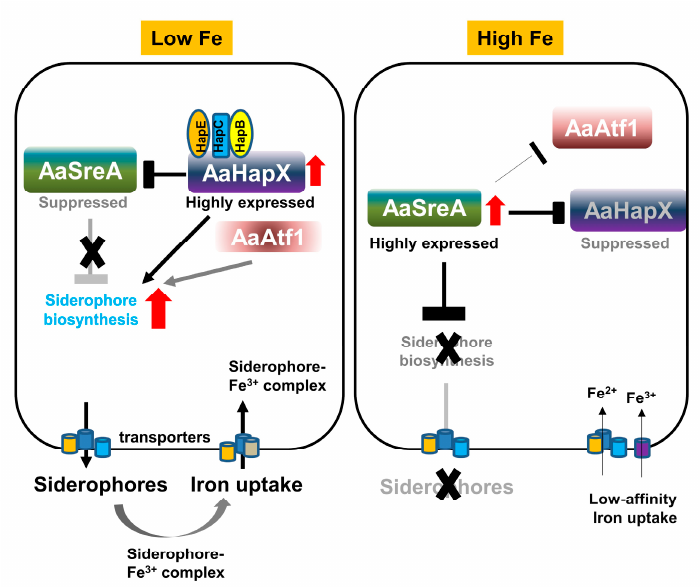
Figure 8. Schematic diagram illustrating the interaction of AaSreA, AaHapX, three CCAAT-binding proteins (AaHapB, AaHapC, and AaHapE), and AaAtf1 in relation to siderophore biosynthesis and iron uptake in A. alternata . Under low-iron conditions, the expression of AaHapX was upregulated. AaHapX was recruited to bind to the AaHapB/AaHapC/AaHapE complex, which in turn suppressed the expression of AaSreA encoding a repressor against siderophore biosynthesis. Without AaSreA, the genes involved in siderophore biosynthesis, transport, and iron uptake were de-repressed. As such, siderophores were produced to chelate iron from the environment. AaAtf1 enhanced the expression of AaNps6 , thus playing a positive role in siderophore production. Under high-iron conditions, the expression of AaSreA was upregulated, which in turn suppressed the expression of AaHapX , AaAtf1 , and genes involved in siderophore biosynthesis, thus preventing siderophore production.